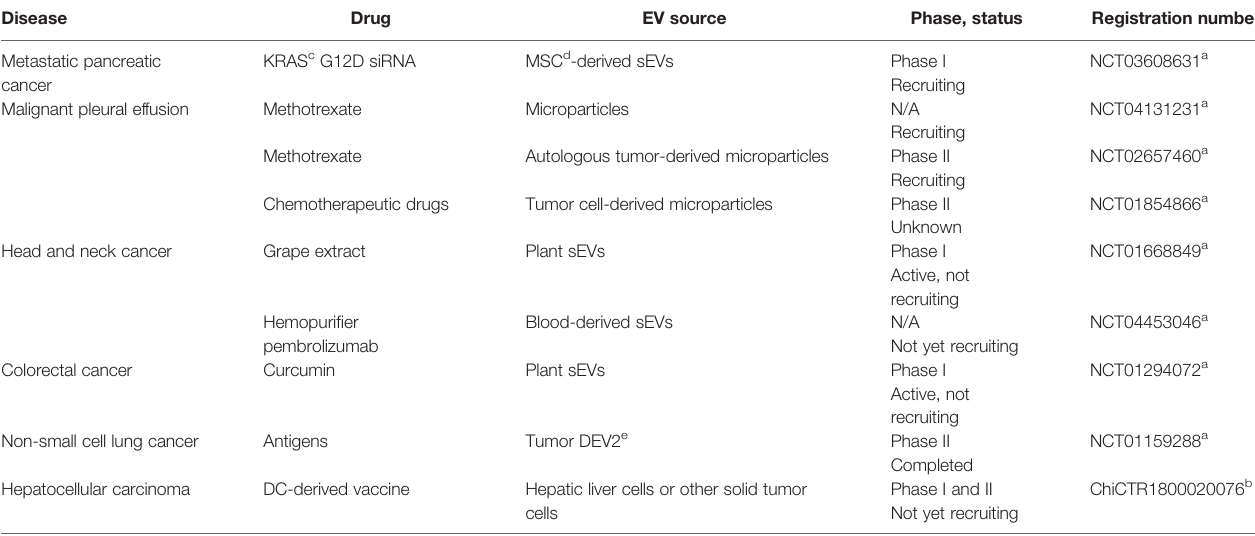
TABLE 3 | Registered clinical trials of sVE-related cancer therapies.